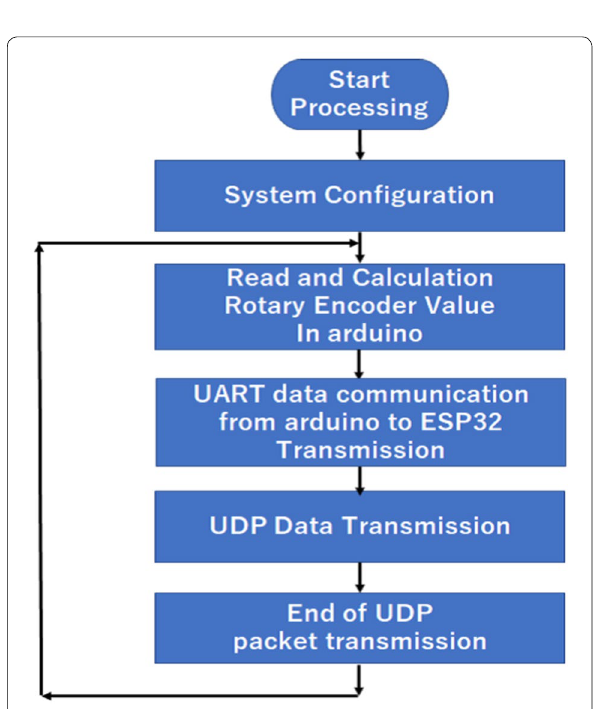
Fig. 10 Flowchart of the firmware for Module B that had a rotary encoder for obtaining distance measurements of linear